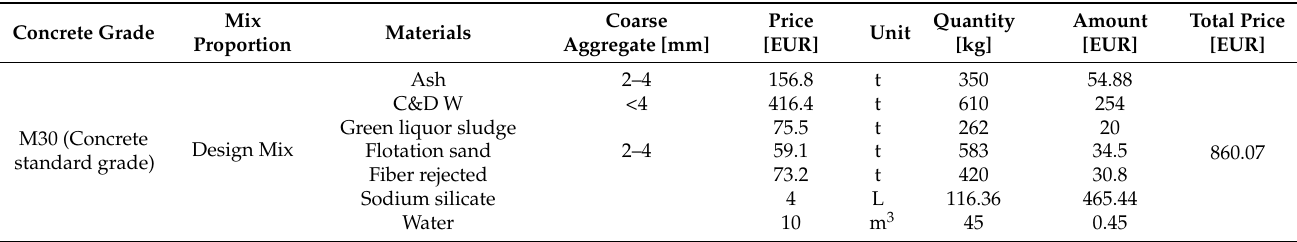
Table 6. Cost production [EUR] of 1 m 3 geopolymer